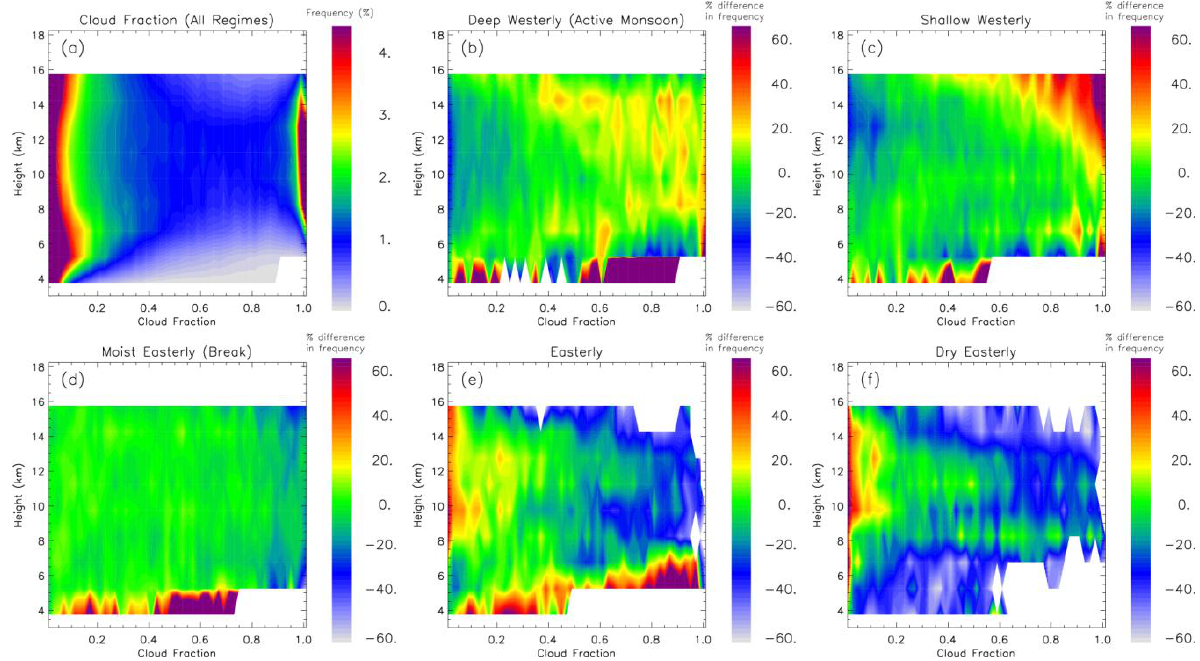
Figure 5: HPDF of cloud fraction when all regimes are included (a). Percentage differences in frequency with Fig. 5. HPDF of cloud fraction when all regimes are included (a) . Percentage differences in frequency with respect to the HPDF of panel respect to the HPDF of panel (a) for the following large-scale atmospheric regimes: Active Monsoon (b), (a) for the following large-scale atmospheric regimes: Active Monsoon (b) , Shallow Westerly (c) , Moist Easterly (d) , Easterly (e) , and Dry Easterly (f) Shallow Westerly (c), Moist Easterly (d), Easterly (e), and Dry Easterly (f).